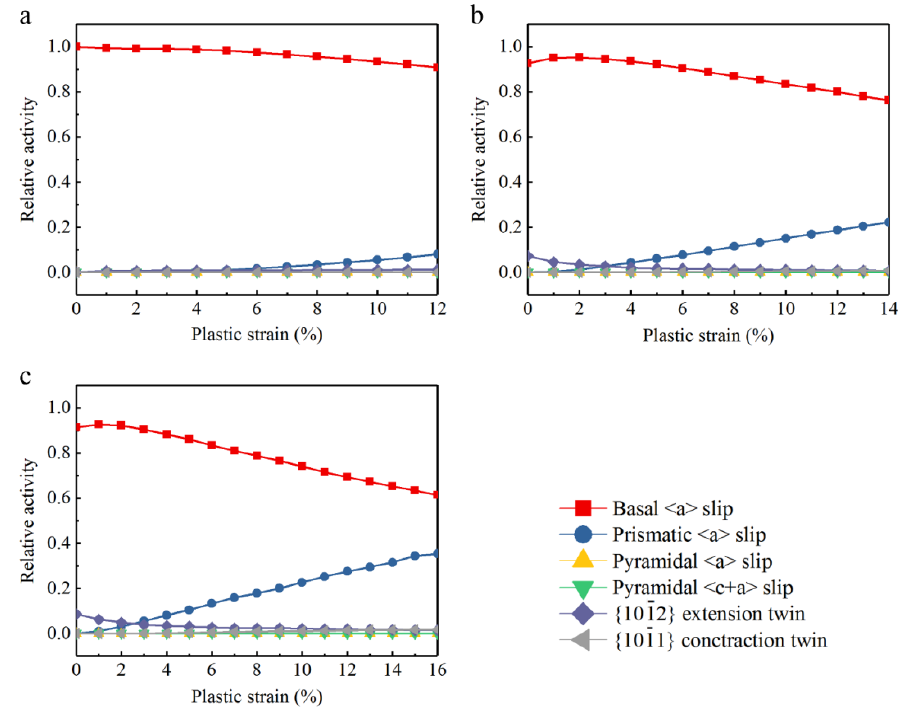
Figure 9. Simulated relative activity of deformation modes: ( a ) Mg, ( b ) Mg–2Al, ( c ) Mg–4Al.